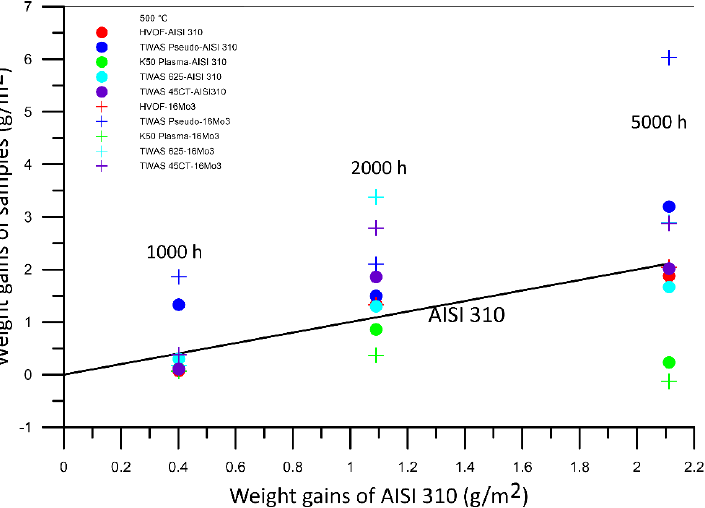
Figure 4. Comparison between the weight gains (determined after the first 500 h of exposure) of AISI 310 and those of samples of various sprayed coatings after exposure at 500 °C.